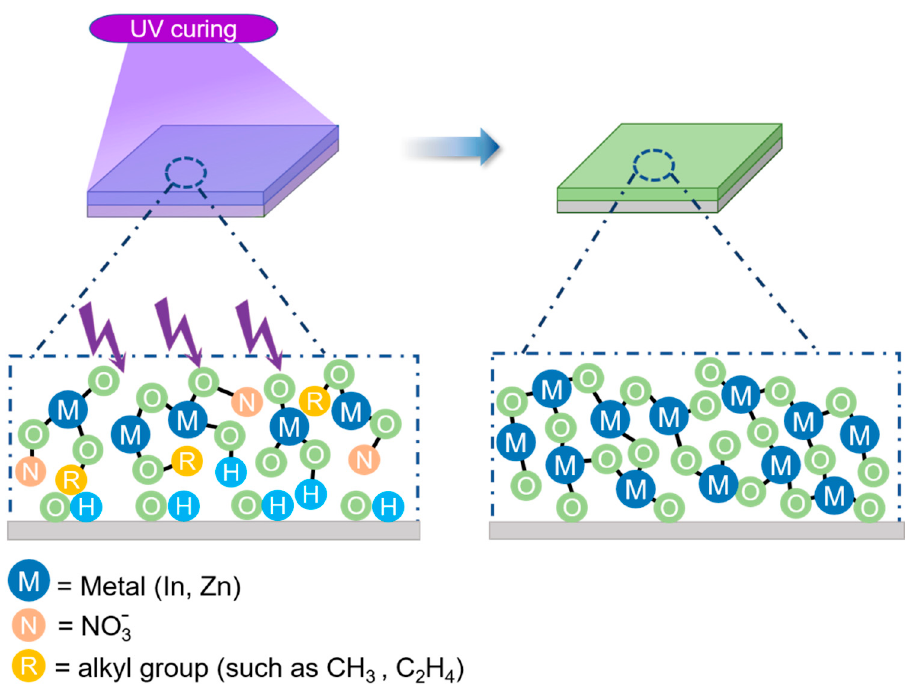
Figure 5. The condensation mechanism of IZO thin films by UV treatment.